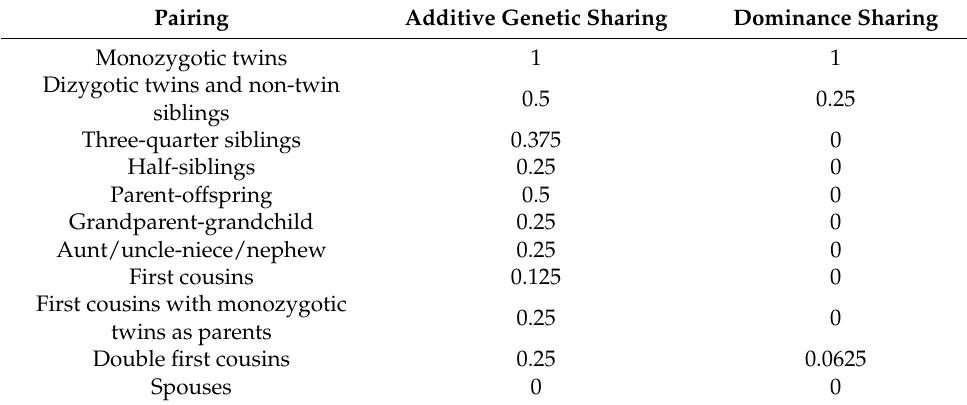
Table 1. Familial relative pairs and expected proportion of genetic sharing. Pairing Additive Genetic